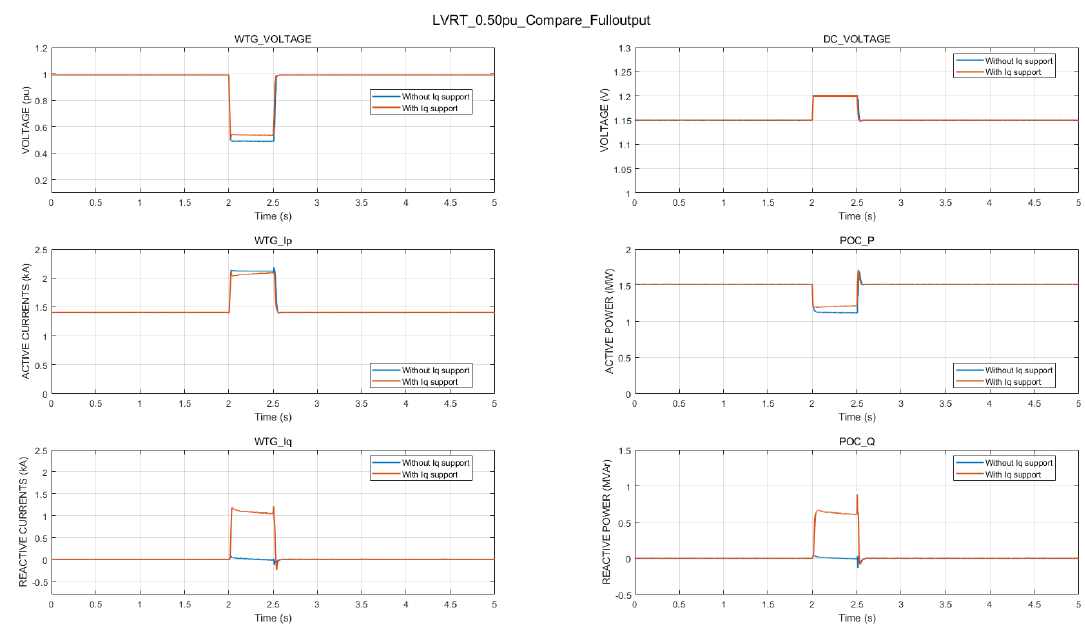
Figure 12. Comparison study of a 0.50 pu LVRT incident with half active power output.